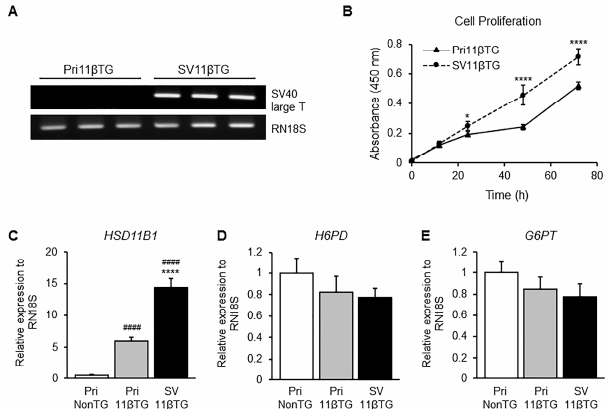
Figure 2. Cell-proliferation rate in SV11 β TG hepatocytes expressing SV40LT and effect of HSD11B1 overexpression on H6PD and G6PT mRNA in hepatic G6PT-H6PD-HSD11B1 triad system. ( A ) The mRNA expression of SV4LT was observed in immortalized SV11 β TG hepatocytes by PCR; ( B ) The proliferation rate of Pri11 β TG ( ▲ ) and SV11 β TG ( ● ) hepatocytes for three days was measured by CCK-8 assay. The rate was significantly elevated in SV11 β TG hepatocytes. Each group was prepared to half-dozen wells, and this experiment was performed twice; ( C ) Expression of HSD11B1 was highly increased; ( D , E ) Expression of H6PD ( D ) and G6PT ( E ) was insignificantly changed by transduction of HSD11B1 gene and immortalization using SV40LT antigen. Relative expression levels of mRNA were investigated by qPCR and normalized to RN18S . These experiments were performed in triplicate and independently three times. Number signs and asterisks indicate significant difference comparing to PriNonTG ( #### p < 0.0001) and Pri11 β TG (* p < 0.05, **** p < 0.0001) hepatocytes, respectively. White, gray and black bars represent PriNonTG, Pri11 β TG and SV11 β TG hepatocytes, respectively.